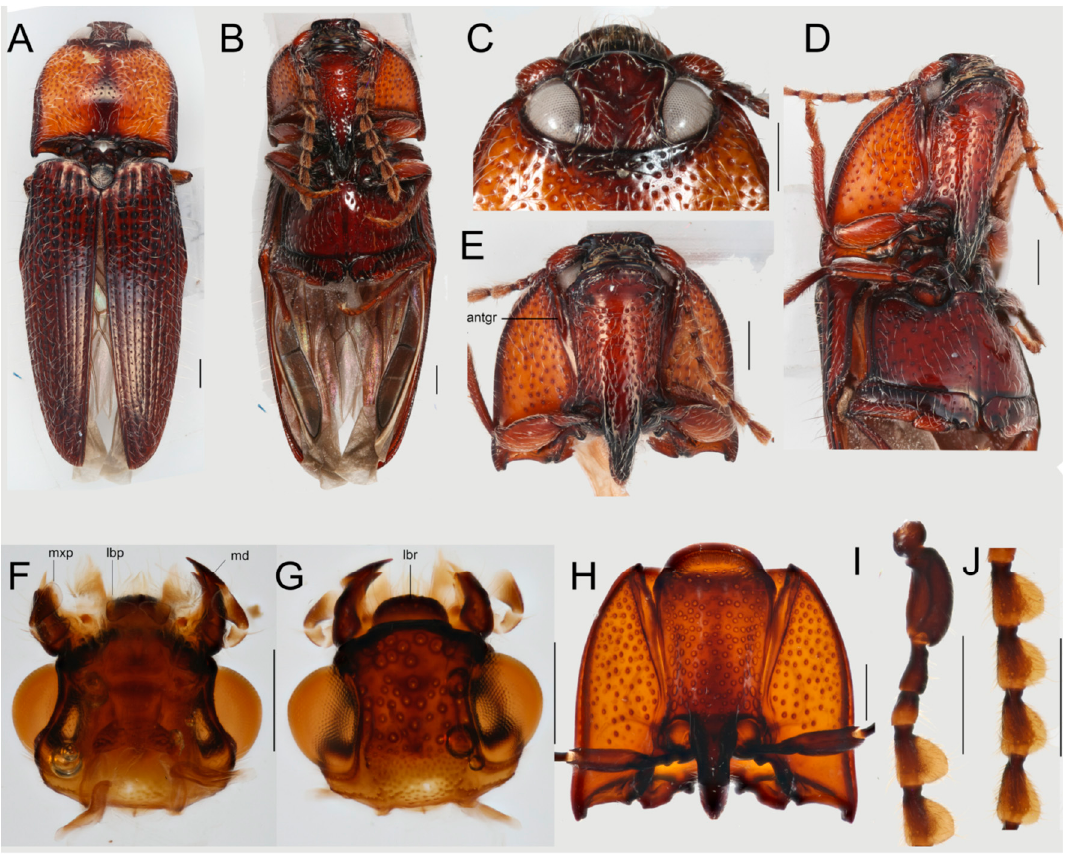
Figure 4. Hapatesus tropicus Neboiss, 1958. ( A ) General appearance, dorsal view; ( B ) ditto, ventral view; ( C ) head, dorsal view; ( D ) head and thorax, ventro-lateral view; ( E ) prothorax, ventral view; ( F ) head, ventral view; ( G ) head, dorsal view; ( H ) prothorax, ventral view; ( I ) basal antennomeres; ( J ) antennomeres 4–7. Scales 0.5 mm. Abbreviations: antgr—antennal groove, mxp—maxillary palpi, lbp—labial palpi, md—mandible.